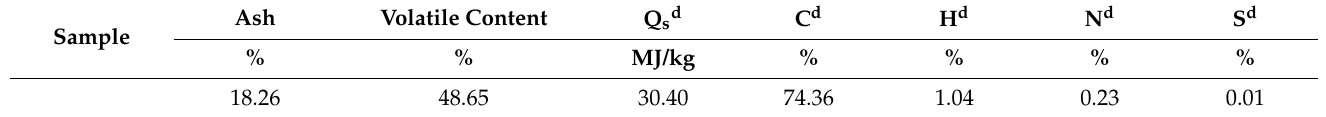
Table 2. Results of the analysis of particulate matter collected from the tested filter.